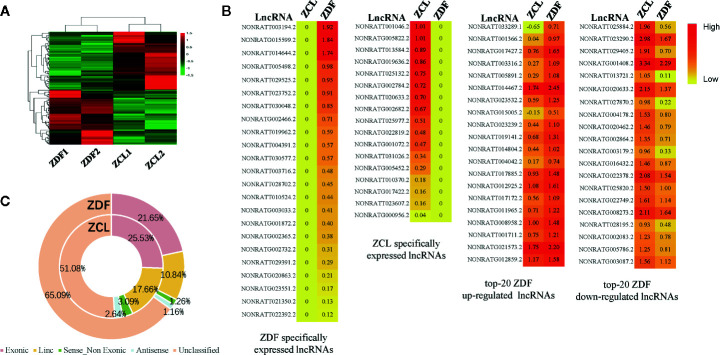
Profiles of differentially expressed lncRNAs between Zucker control lean (ZCL) and Zucker diabetic fatty (ZDF) rats. (A) Heatmap showing the differentially expressed lncRNAs between ZCL and ZDF rats (p < 0.05, |fold-change| ≥ 2, FPKM ≥ 1). The color key indicates the relative expression level (log10 (FPKM)) between ZCL and ZDF rats, ranging from green (low expression) to red (high expression). (B) Heatmaps showing the representative differentially expressed lncRNAs between ZCL and ZDF rats. Specifically expressed differentially expressed lncRNAs and top 20 up- and down-regulated DEGs are separately exhibited (B). The colors indicate the expression level (log10 (FPKM)), ranging from yellow (low expression) to red (high expression). The value of are shown in the cells. (C) The proportions of lncRNA types between ZCL and ZDF rats. The lncRNAs were classified into five types based on the position in the genome, including exonic, lincRNA, sense non-exonic, antisense and unclassified lncRNAs. Each type of circRNA is represented by the indicated color box.